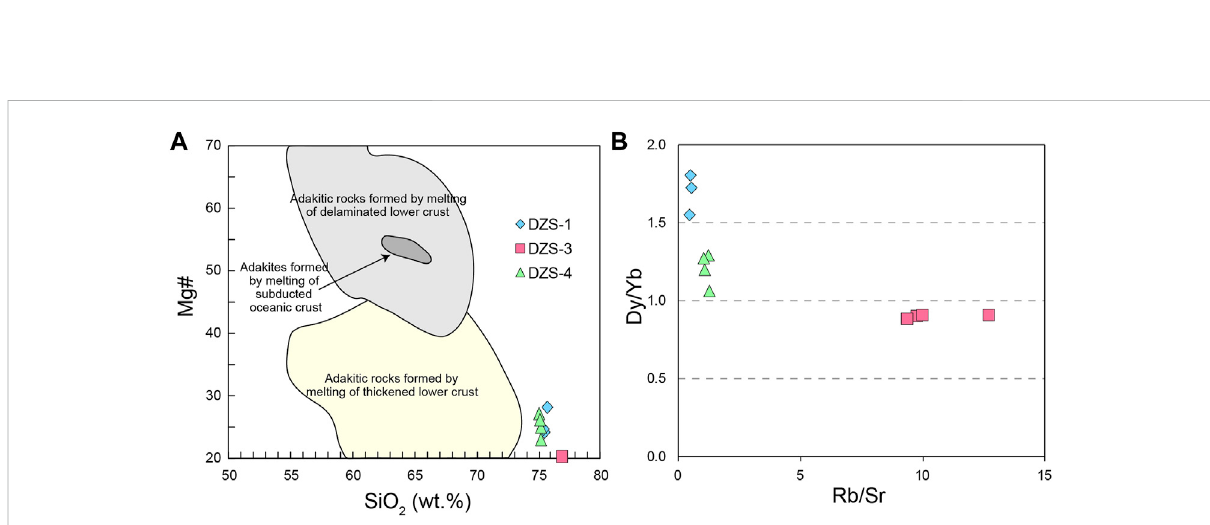
FIGURE 10 Mg # vs.SiO 2 (A) andDy/Ybvs.Rb/Sr (B) diagrams.Adakite fi eldsareadoptedfromSenandDunn(1994),RappandWatson(1995),andRappetal. (1999) and references